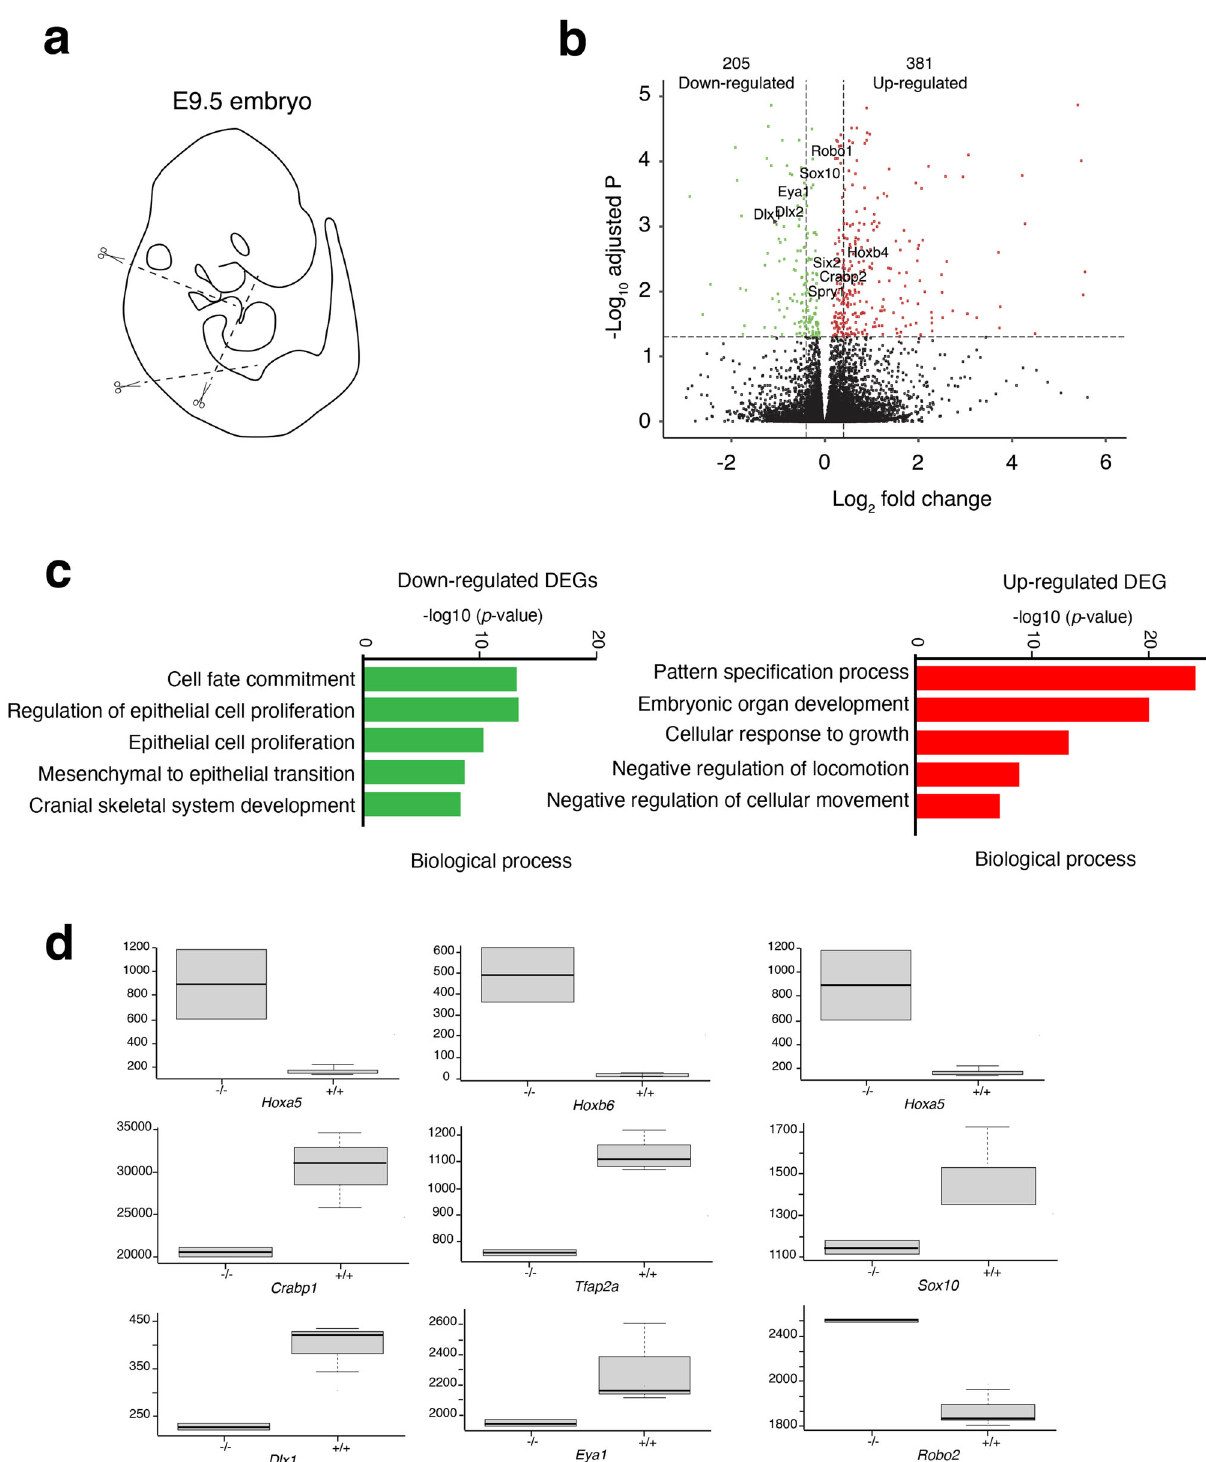
Fig. 6 | Transcriptomic analysis identi fi es Hoxa1 targets involved in migration of neural crest cells. a Scheme showing which region was used to perform RNA- seq analysis on Hoxa1 − / − vs WT embryos. b Volcano plot of fold changes and cor- responding FDR (False Discovery Rate) value for each RNA after comparison of Hoxa1 − / − andWTembryos.TheredandgreendotsrepresentRNAswithfoldchange >2.0 and FDR<0.05. The black dots represent RNAs with fold change <2.0 and FDR>0.05. The statistical test used for data analysis is package R EnhancedVol- cano. c Gene ontology (GO) analysis performed with ClusterPro fi ler system